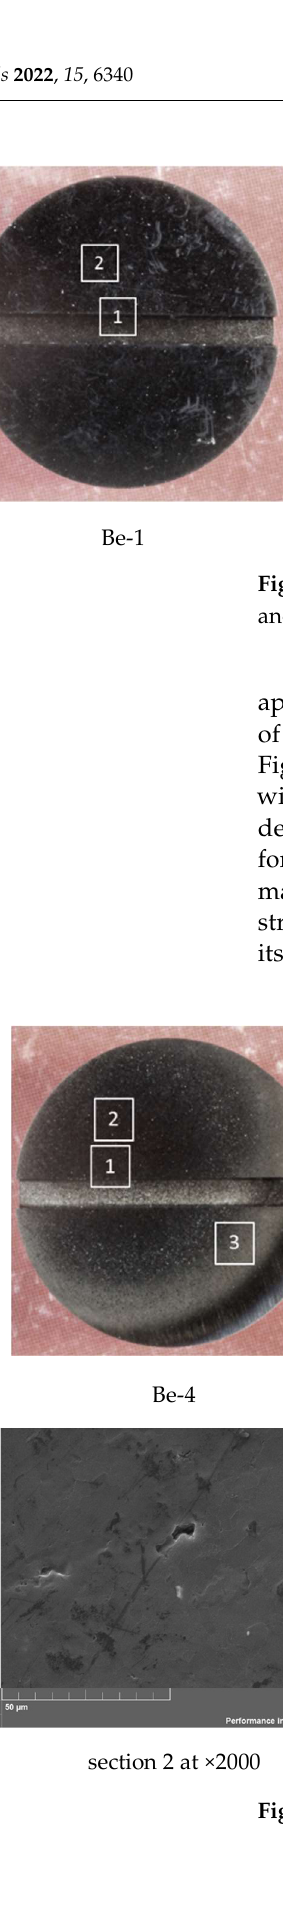
Figure 5. Microstructure of the samples cross section (360 °С): ( a ) Be-1 (10 impulses); and ( b ) Be-4 (100 impulses).